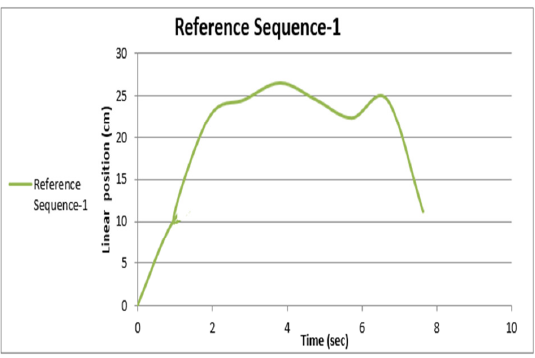
Fig. 12. Reference sequence for the first